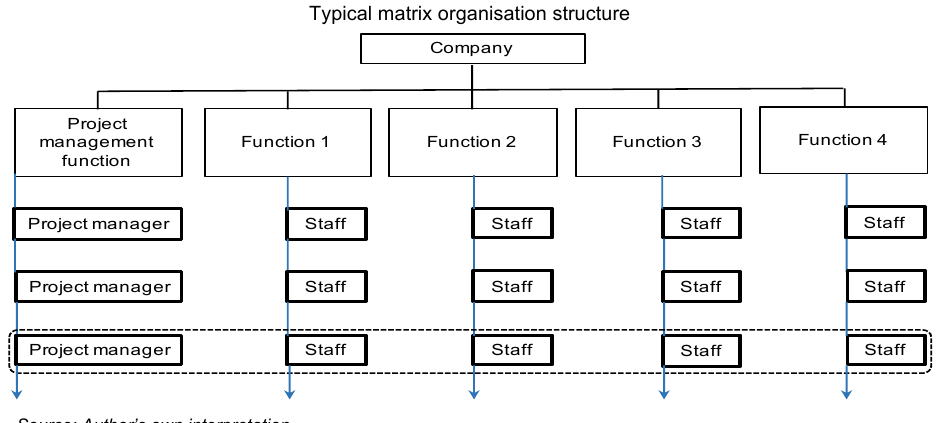
Figure 1 Typical matrix organisation